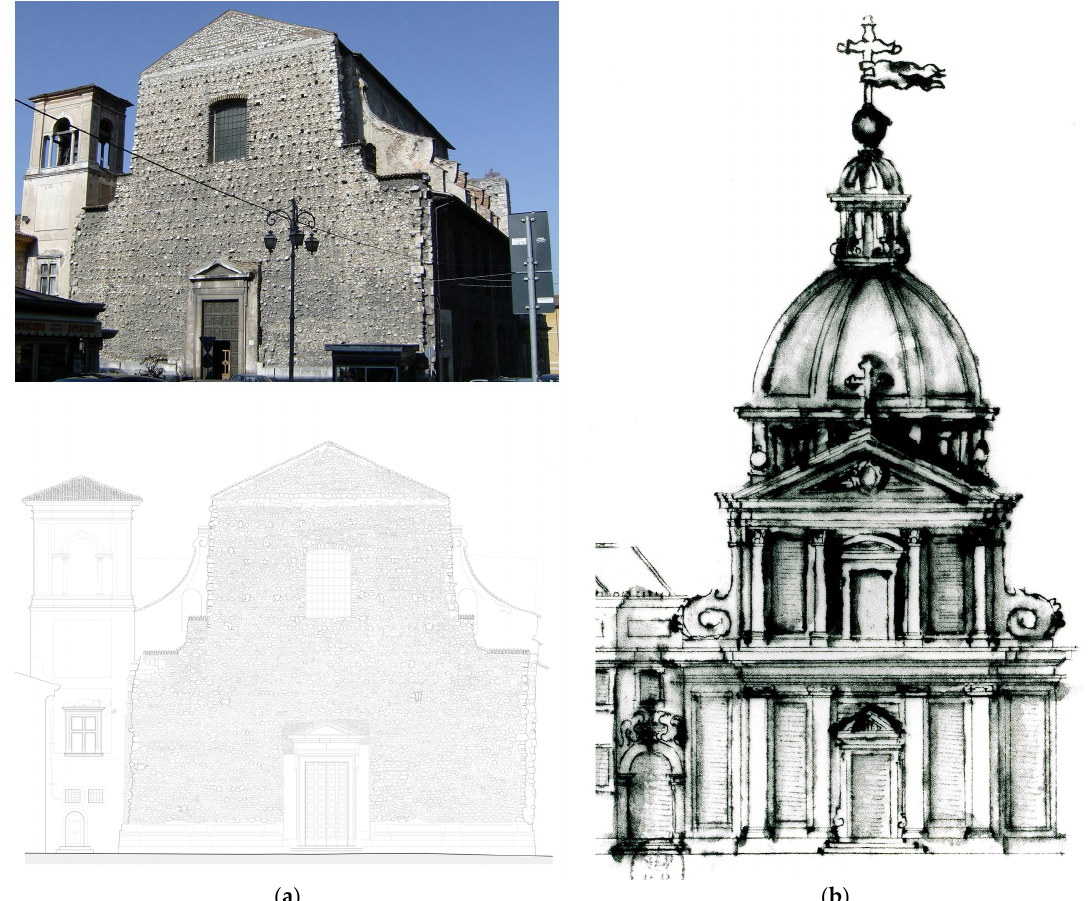
Figure 2. ( a ) The incomplete facade of St. Margherita; ( b ) Unrealized project of the church facade by Agazio Stoia,